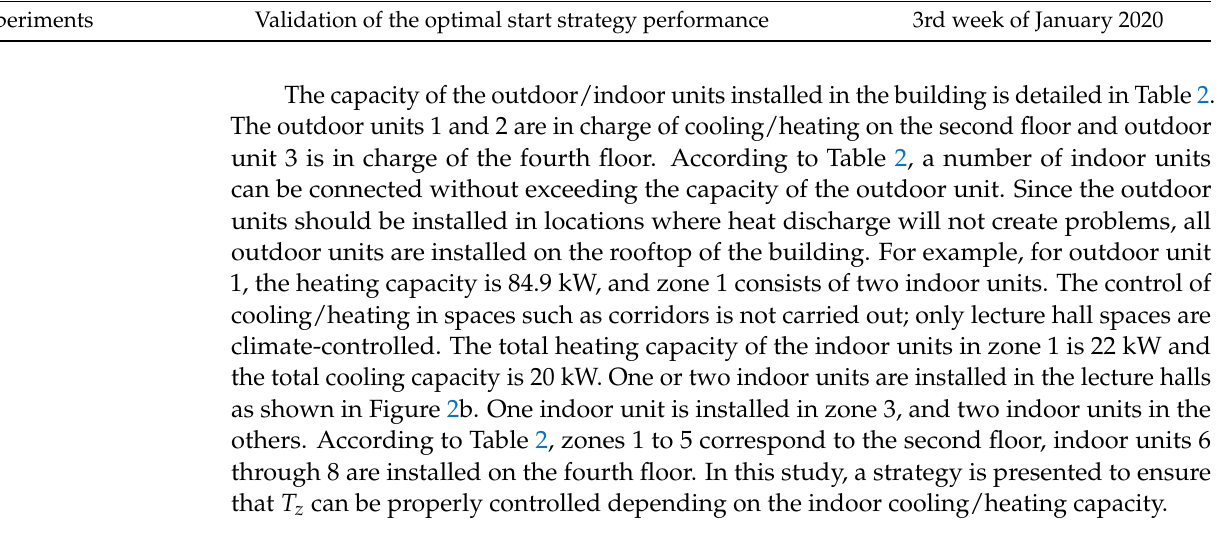
Table 2. Cooling and heating capacity of outdoor/indoor